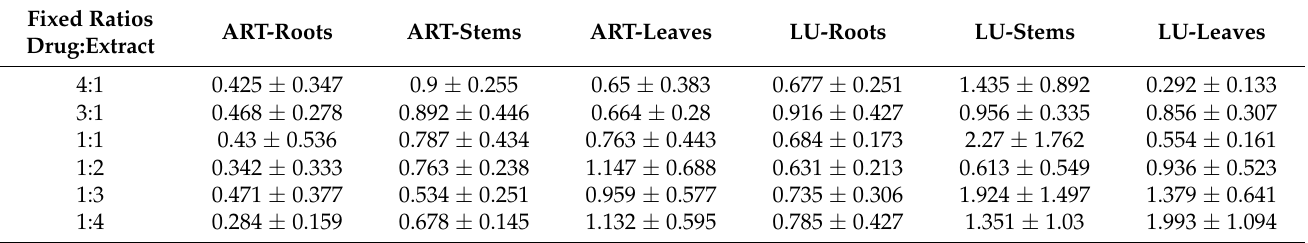
Table 3. Mean sum FIC 50 values for artemether and lumefantrine combinations with S. longipeduncu- lata extracts against D6 strain of P. falciparum .